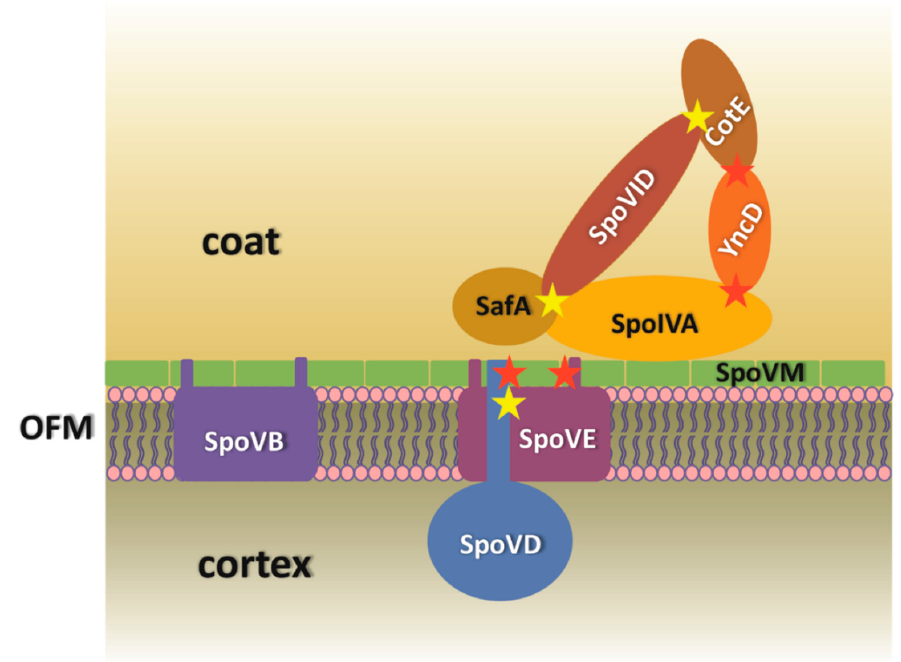
Figure 6. Model of the interactions between the coat proteins and the cortex synthesizing proteins. SpoIVA together with SpoVM, SpoVID, SafA and CotE build the basic structure of the spore coat through direct interactions. YncD is in contact with two of the morphogenetic proteins, SpoIVA and CotE. The localization of the SpoVD–SpoVE protein complex is dependent on SpoVM. The N-terminal domain (SpoVD) or N- and C-terminal domains (SpoVE) form physical contacts with SpoVM. The interactions discovered in this work are marked with red stars, previously known interactions are marked with yellow stars. The Bacterial Two Hybrid System (BACTH) assay did not reveal any physical contacts between SpoVB and these proteins. (OFM—outer forespore